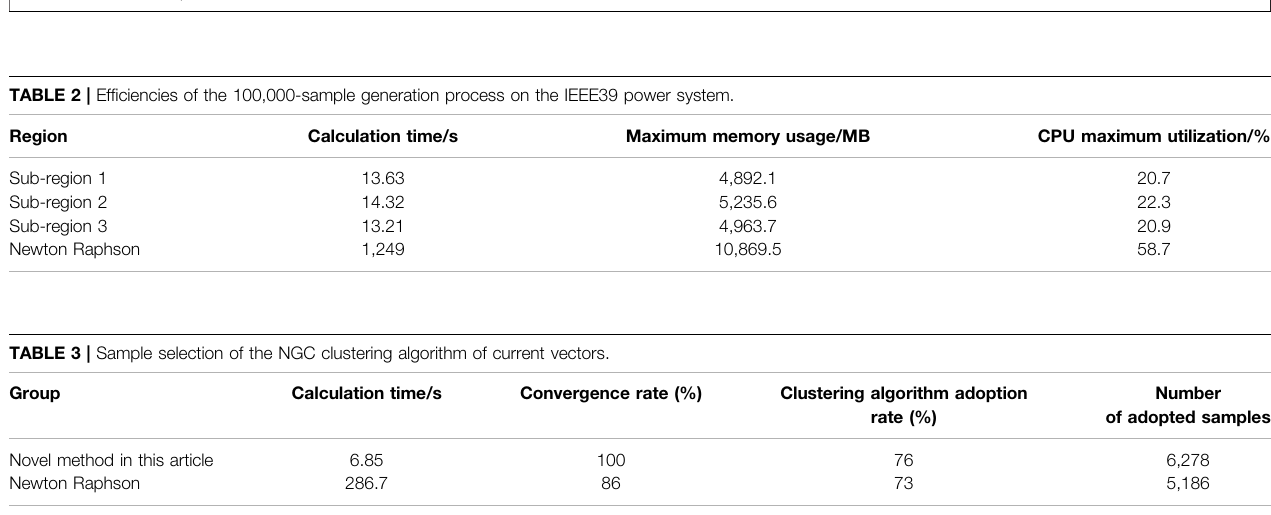
FIGURE 7 | Schematic diagram of the Thevenin equivalent for power systems. (A) Power system model before the Thevenin equivalent. (B) Power system model after the Thevenin equivalent.